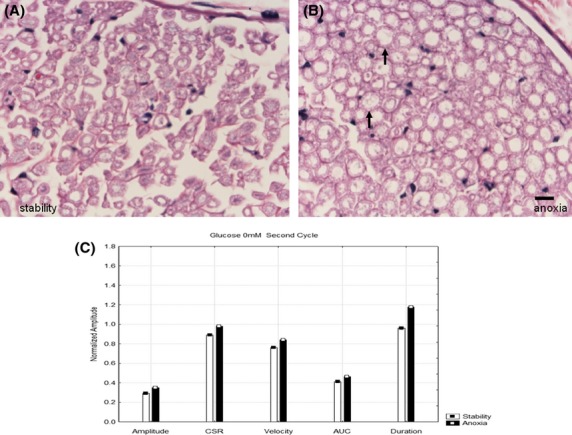
Hematoxylin and eosin stained nerve cross sections at 60×. (A) Nerve maintained in fully oxygenated state at 37°C throughout the experiment with no glucose in the perfusate. There is mild axonal swelling. (B) A second nerve exposed to five cycles of anoxia showing diffuse axonal swelling with preservation of myelin as indicated by the arrows. The line at the bottom of the image represents 10 microns. (C) Neurophysiological results in these same two nerves after the second cycle of anoxia. There were no responses in either case after the second cycle.